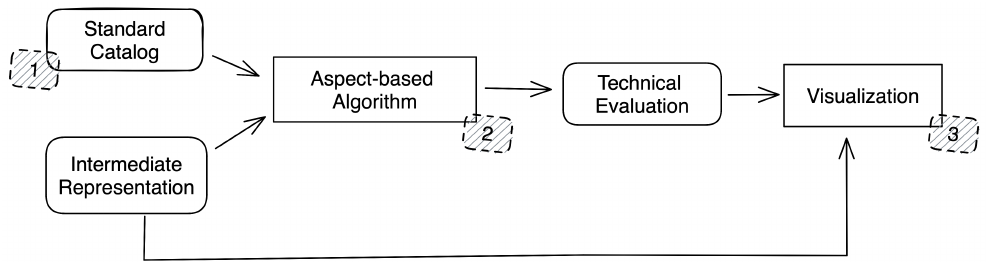
Figure 7. Reasoning designed